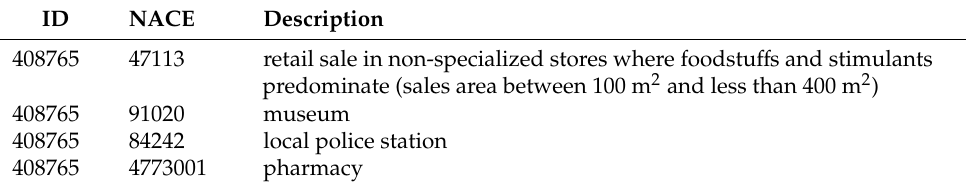
Table 2. Examples of enterprise activity codes (NACE 2008)